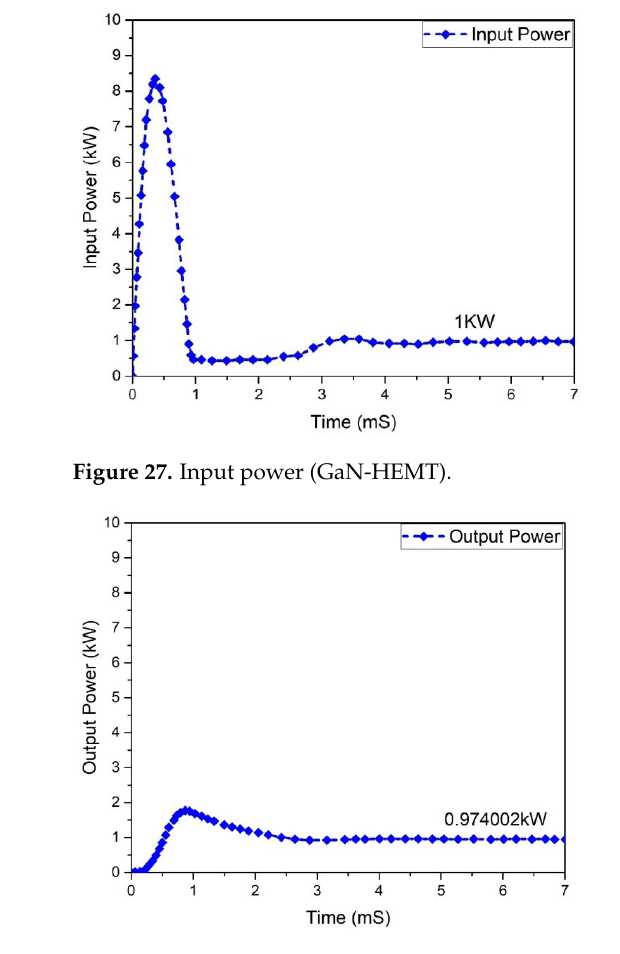
Figure 28. Output power (GaN-HEMT).